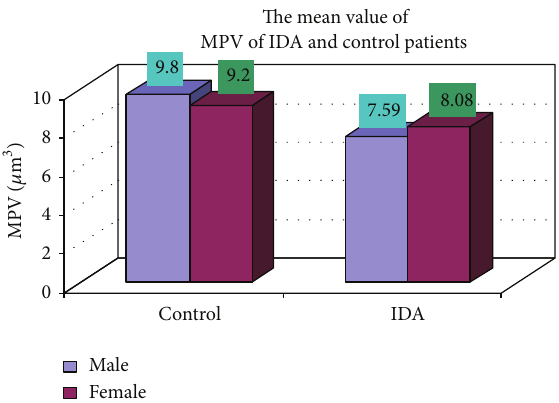
Figure 12: Showing the mean value of MPV of control and iron deficiency